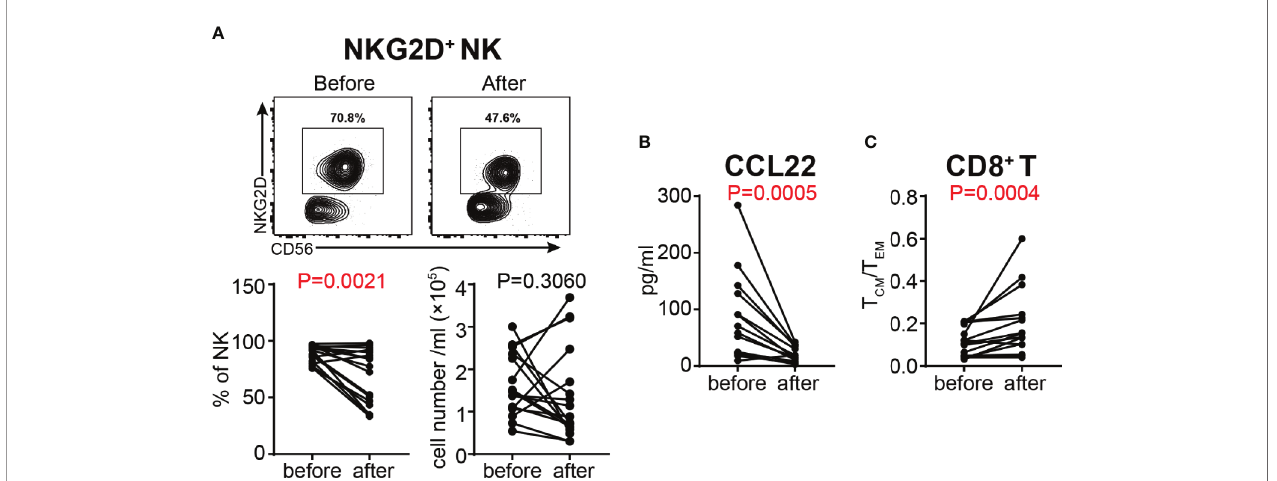
FIGURE 7 | Assessment of the activation status of NK cells and the differentiation status of T cells in VKH patients before and after GC treatment. (A) The absolute number and proportion of NKG2D + NK cells. (B) plasma level of CCL22 (pg/ml) in HCs and VKH patients. (C) The T CM /T EM ratio of CD8 + T cells. Statistical analysis was performed using Wilcoxon test.